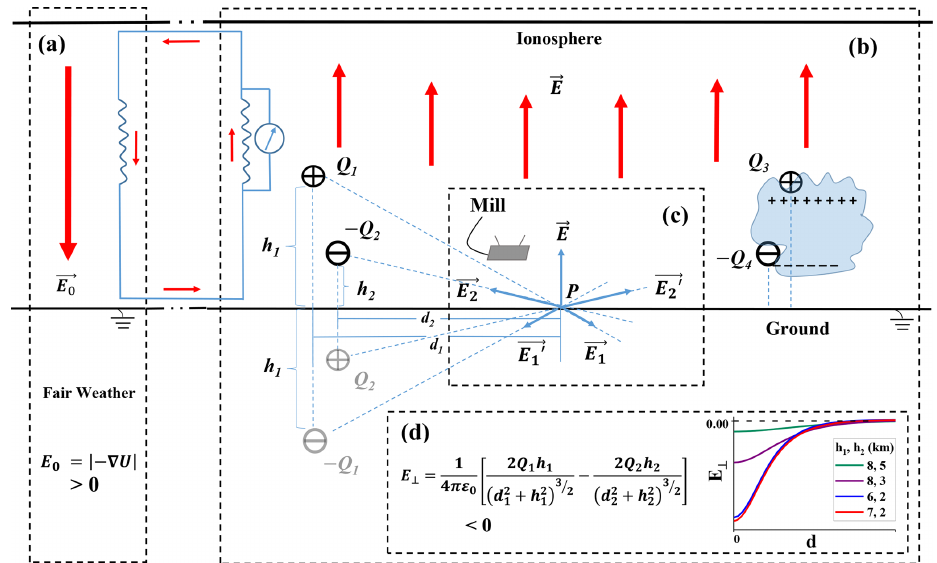
Figure A1. The diagram illustrates the global electric circuit. (a) The atmospheric electric field under fair weather with a downward field returning from the ionosphere. (b) The dynamo area, with thunderstorms generating an upward electric field towards the ionosphere. The electric field intensity E ⊥ could be deduced through the electric imaging method. (c) The deduced vertical electric field intensity at any point P within the thundercloud. (d) The calculated E ⊥ based on the electric imaging